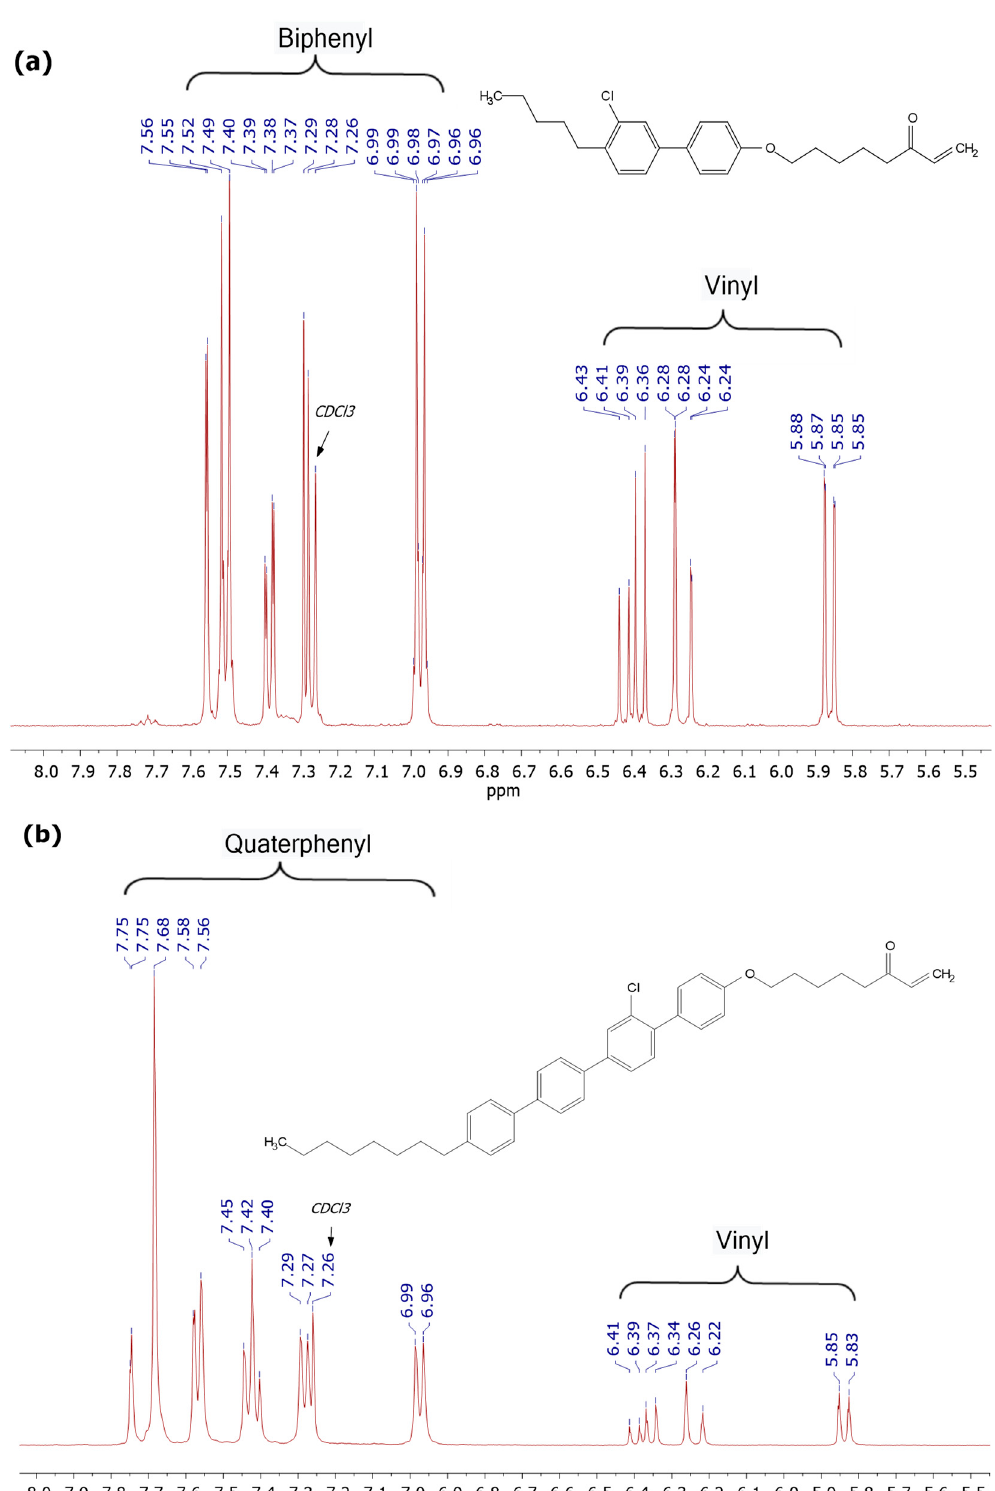
Figure 5. The 1 H spectra of BVK ( a ) and QVK ( b ) in CDCl 3 . All the synthesized aryl vinyl ketones contain bulky aromatic substituents linked to soft methylene units. It may be supposed that these monomers may exhibit liquid crystalline behavior. To verify it, we analyzed their DSC thermograms and optical textures obtained by means of